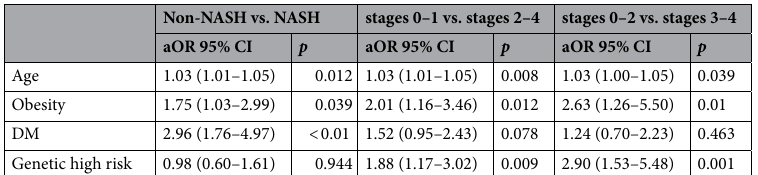
Table 3. Multivariate logistic regression analysis of age, obesity, DM and genetic high risk. aOR adjusted odds ratio, CI confidence interval, DM diabetes mellitus, NASH non-alcoholic steatohepatitis.